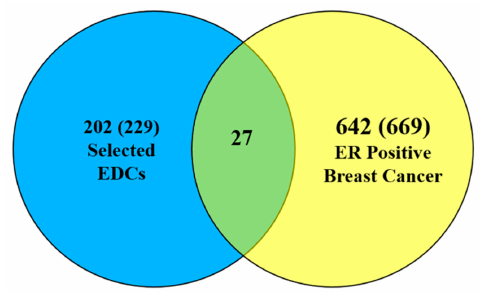
Figure 2. A Venn diagram of the list of genes common between ER-positive breast cancer and the four EDCs.